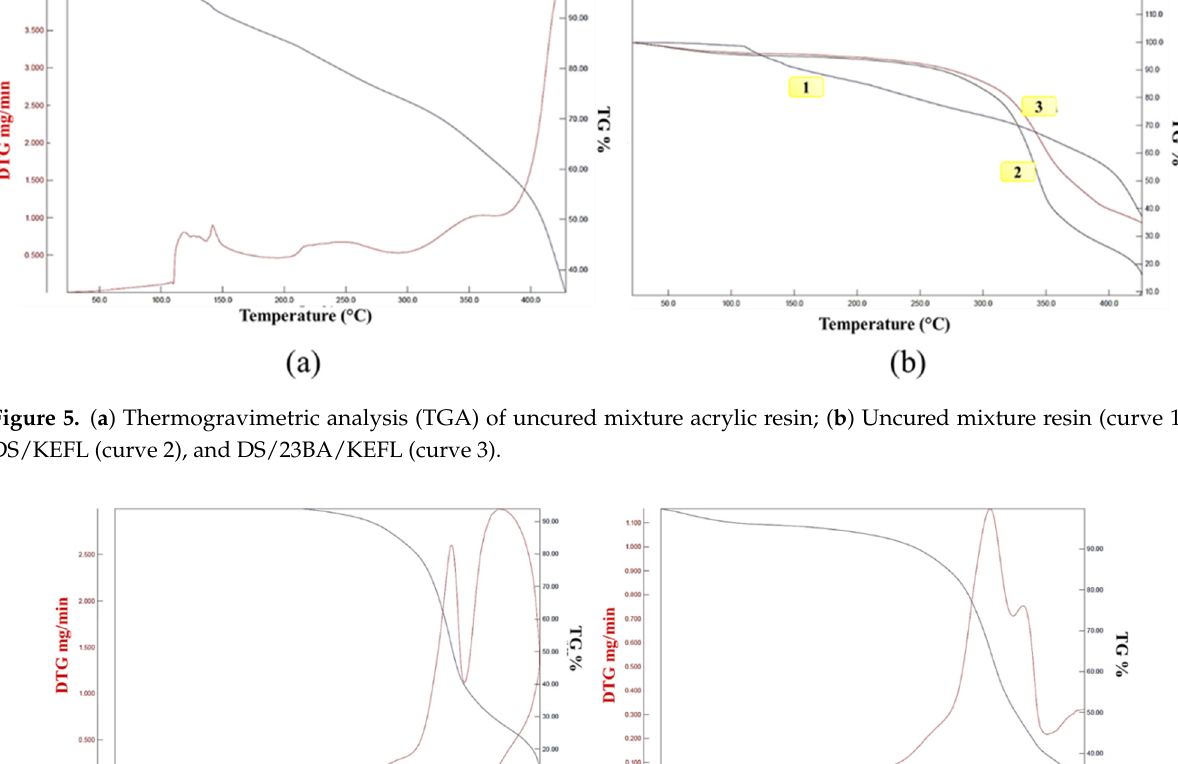
Figure 5. ( a ) Thermogravimetric analysis (TGA) of uncured mixture acrylic resin; ( b ) Uncured mixture resin (curve 1), DS/KEFL (curve 2), and DS/23BA/KEFL (curve 3).